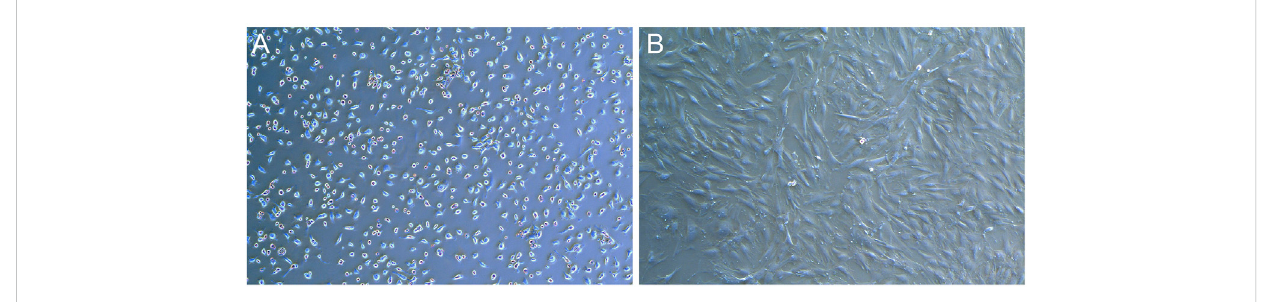
FIGURE 5 Photos of BMSCs in SD rats (X50). (A) Photos of primary cells. (B) Photos of the third generation